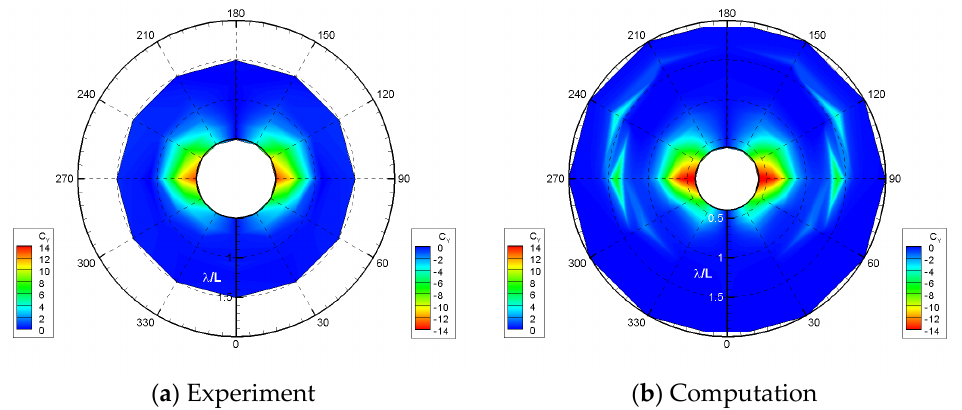
Figure 15. Polar diagram of sway wave drift force: KVLCC2, V = 6 knots.